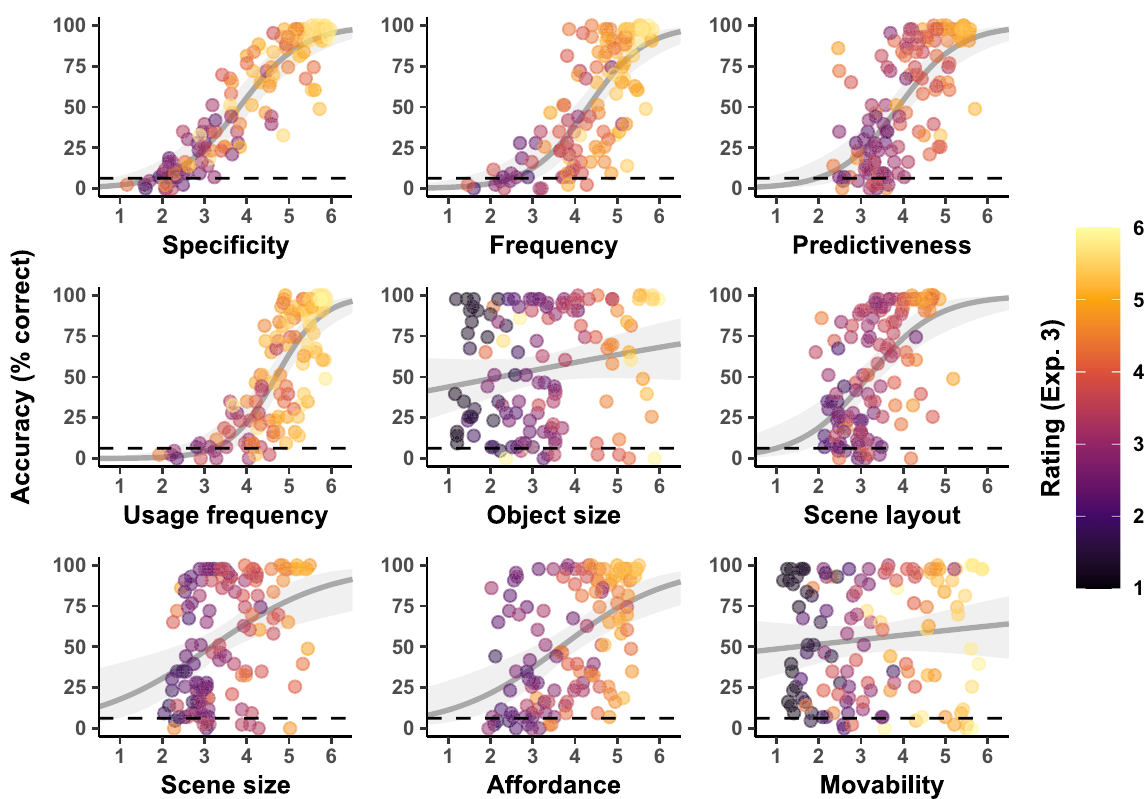
Figure 5. Observed basic-level scene categorization accuracy in Experiment 4 as a function of different ratings of object properties. Points represent the respective rating and accuracy averaged across participants for each individual image in Experiment 4. The points’ colours indicate the mean ratings for images showing the same object in Experiment 3. Smoothed lines are fixed-effect binomial approximations for illustrative purposes only. The dashed lines indicate the expected chance level in the basic-level scene categorization task